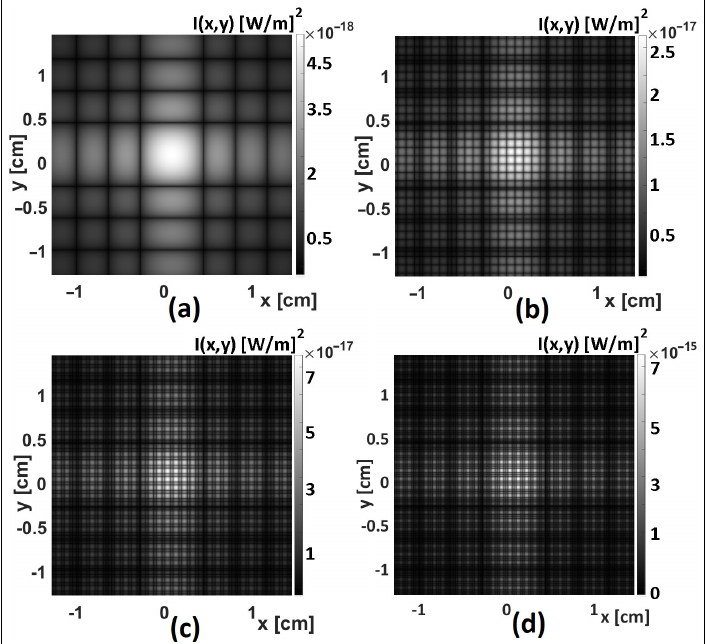
Figure 2. Intensity plots of the diffraction patterns for 2 × 2, 3 × 3, 4 × 4 and 512 × 512 pixels cases in ( a ), ( b ), ( c ), and ( d ) respectively. We include color bars of the intensity [W/m 2 ] on the right side of each